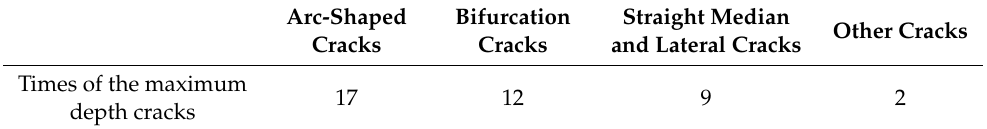
Table 2. Proportion of cracks with maximum depth.